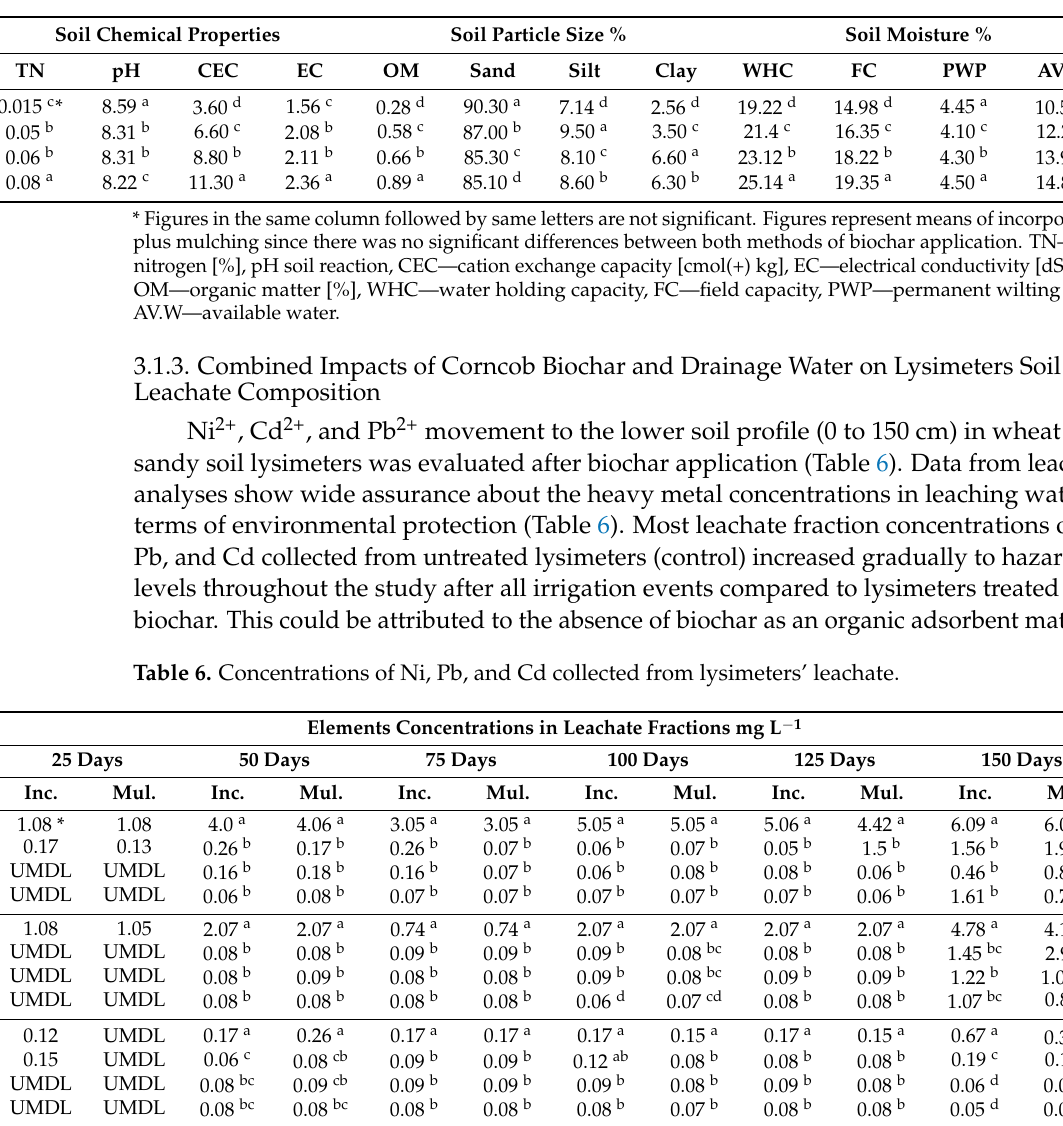
Table 5. Selected sandy soil properties changed after corncob biochar